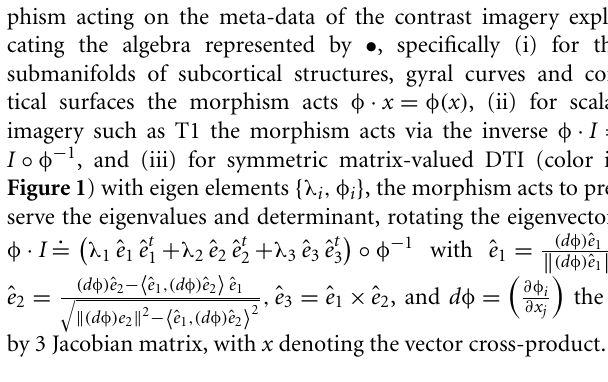
parcellated into multiple cortical and subcortical areas including deep gray and white matter structures based on anatomical features (anatomical parcellation) as well as functional parcellation based on cytoarchitecture, vascular territories, and anatomical and functional